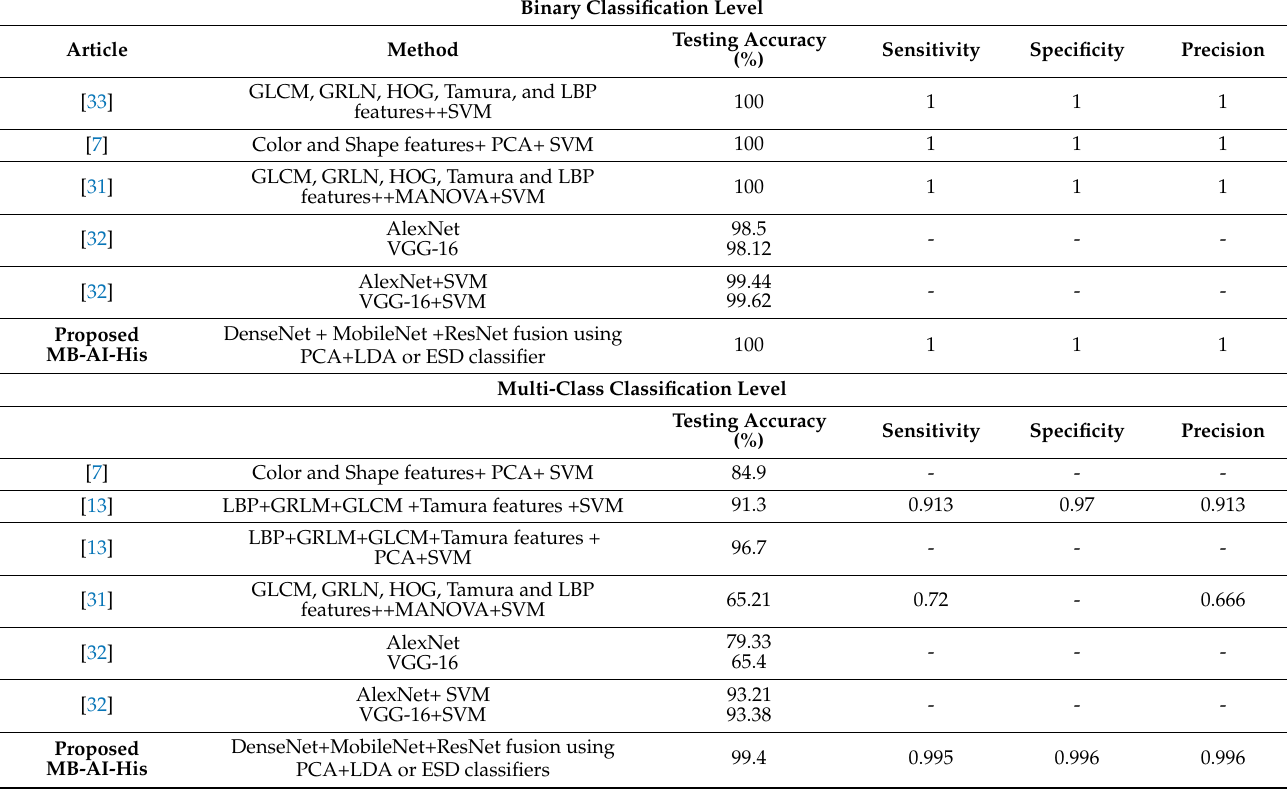
Table 12. A comparison between MB-AI-His and related CADx based on the same dataset. Binary Classification Level